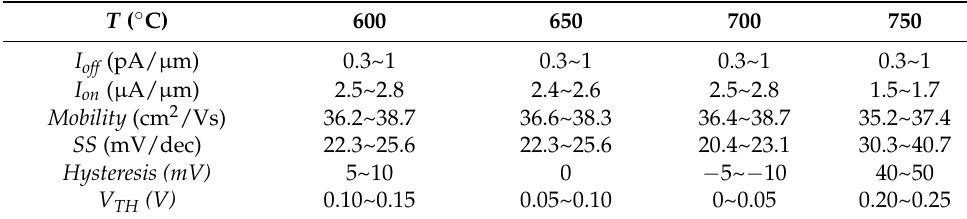
Table 3. Zr 0.475 Al 0.05 O y NCFETs with different annealing temperatures ( T ) extracted from their trans- fer curves.